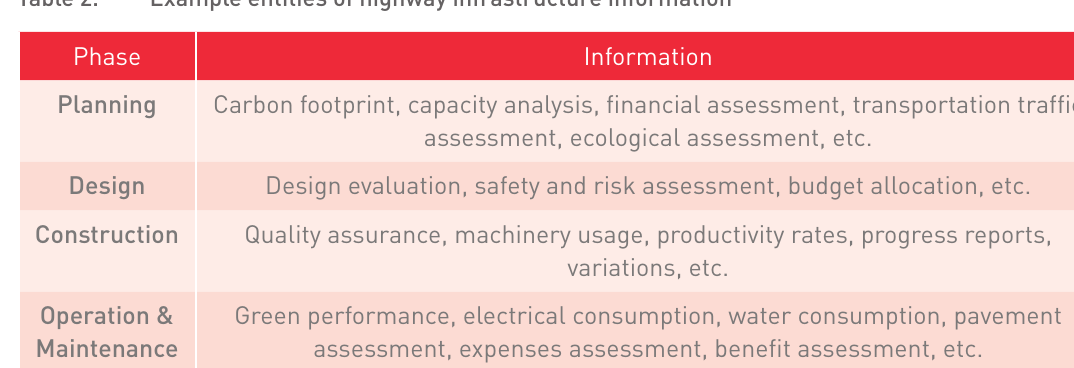
Figure 4. Data, information and decision-making integration Example entities of highway infrastructure information